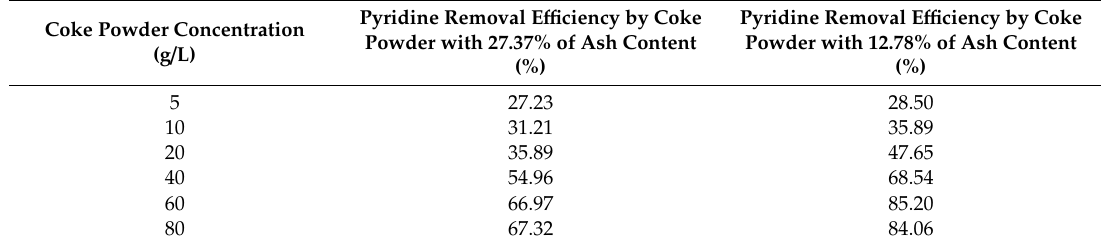
Table 4. Removal e ffi ciency of pyridine by coke powder with di ff erent ash Table 4. Removal efficiency of pyridine by coke powder with different ash contents.